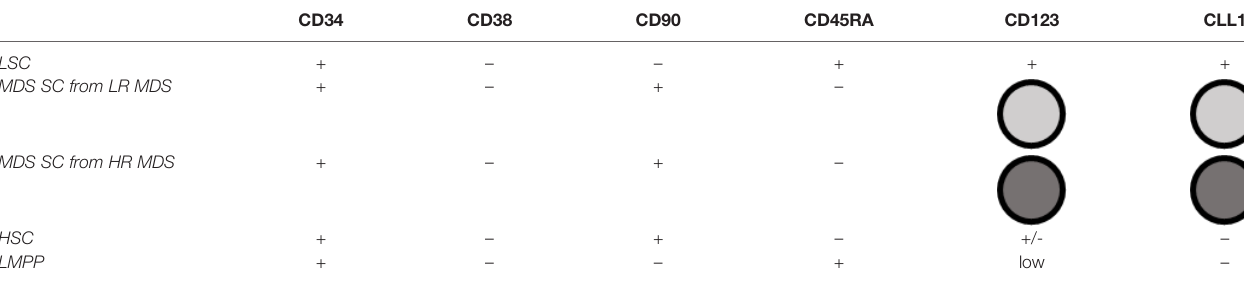
TABLE 1 | Phenotypic characteristics of malignant stem cells and healthy progenitors.